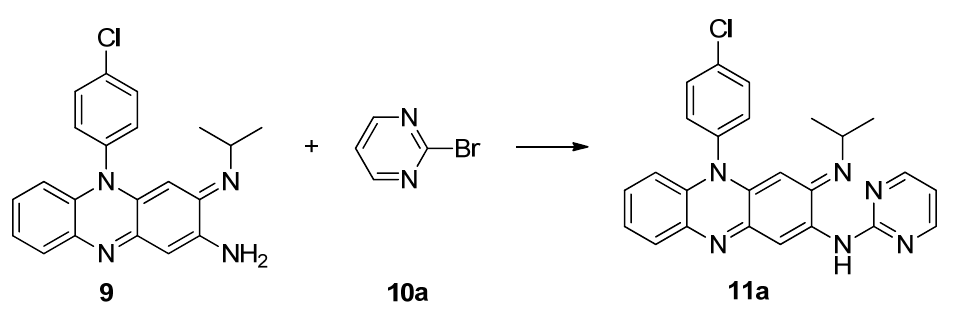
Table 1. Optimization of N -arylation of riminophenazines a,b